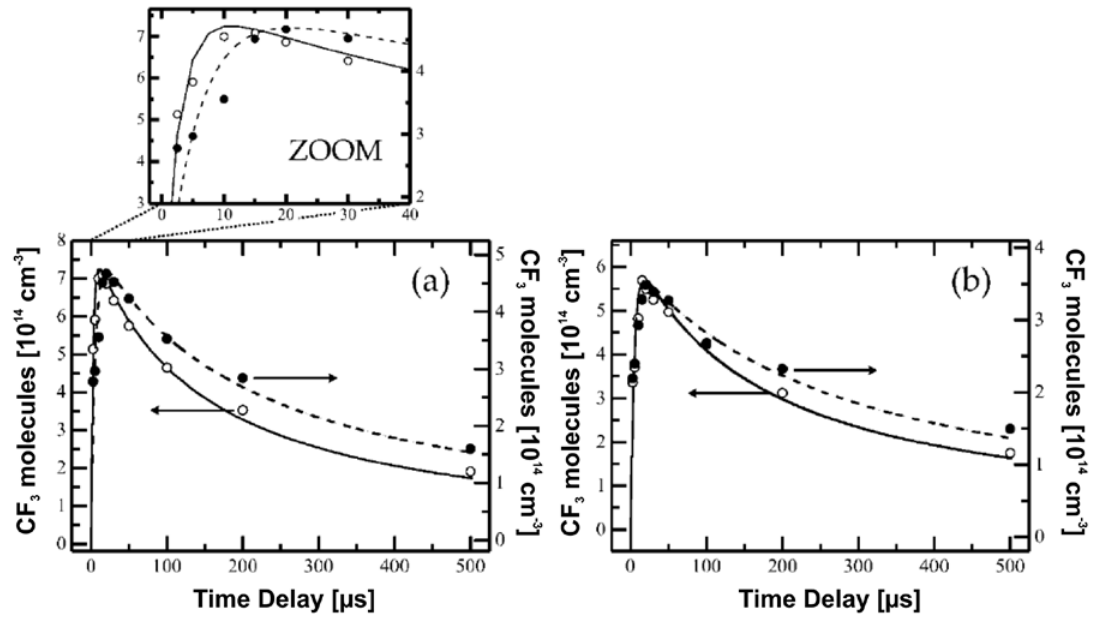
Figure 10. CF number densities monitored as a function of time after the CF 3 pulse for different pump pulse energies [ (a ) 29 mJ/pulse and ( b ) 14 mJ/pulse]. Results are plotted for two pressure values: 5.32 mbar (open symbol/solid) and 2.66 mbar (full symbol/dashed), respectively (reprinted with permission from [57]. Copyright 2008. American Chemical